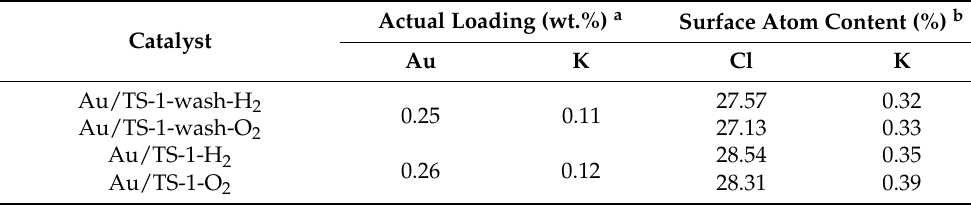
Table 3. The elemental content of Au, K, and Cl in the studied catalysts.